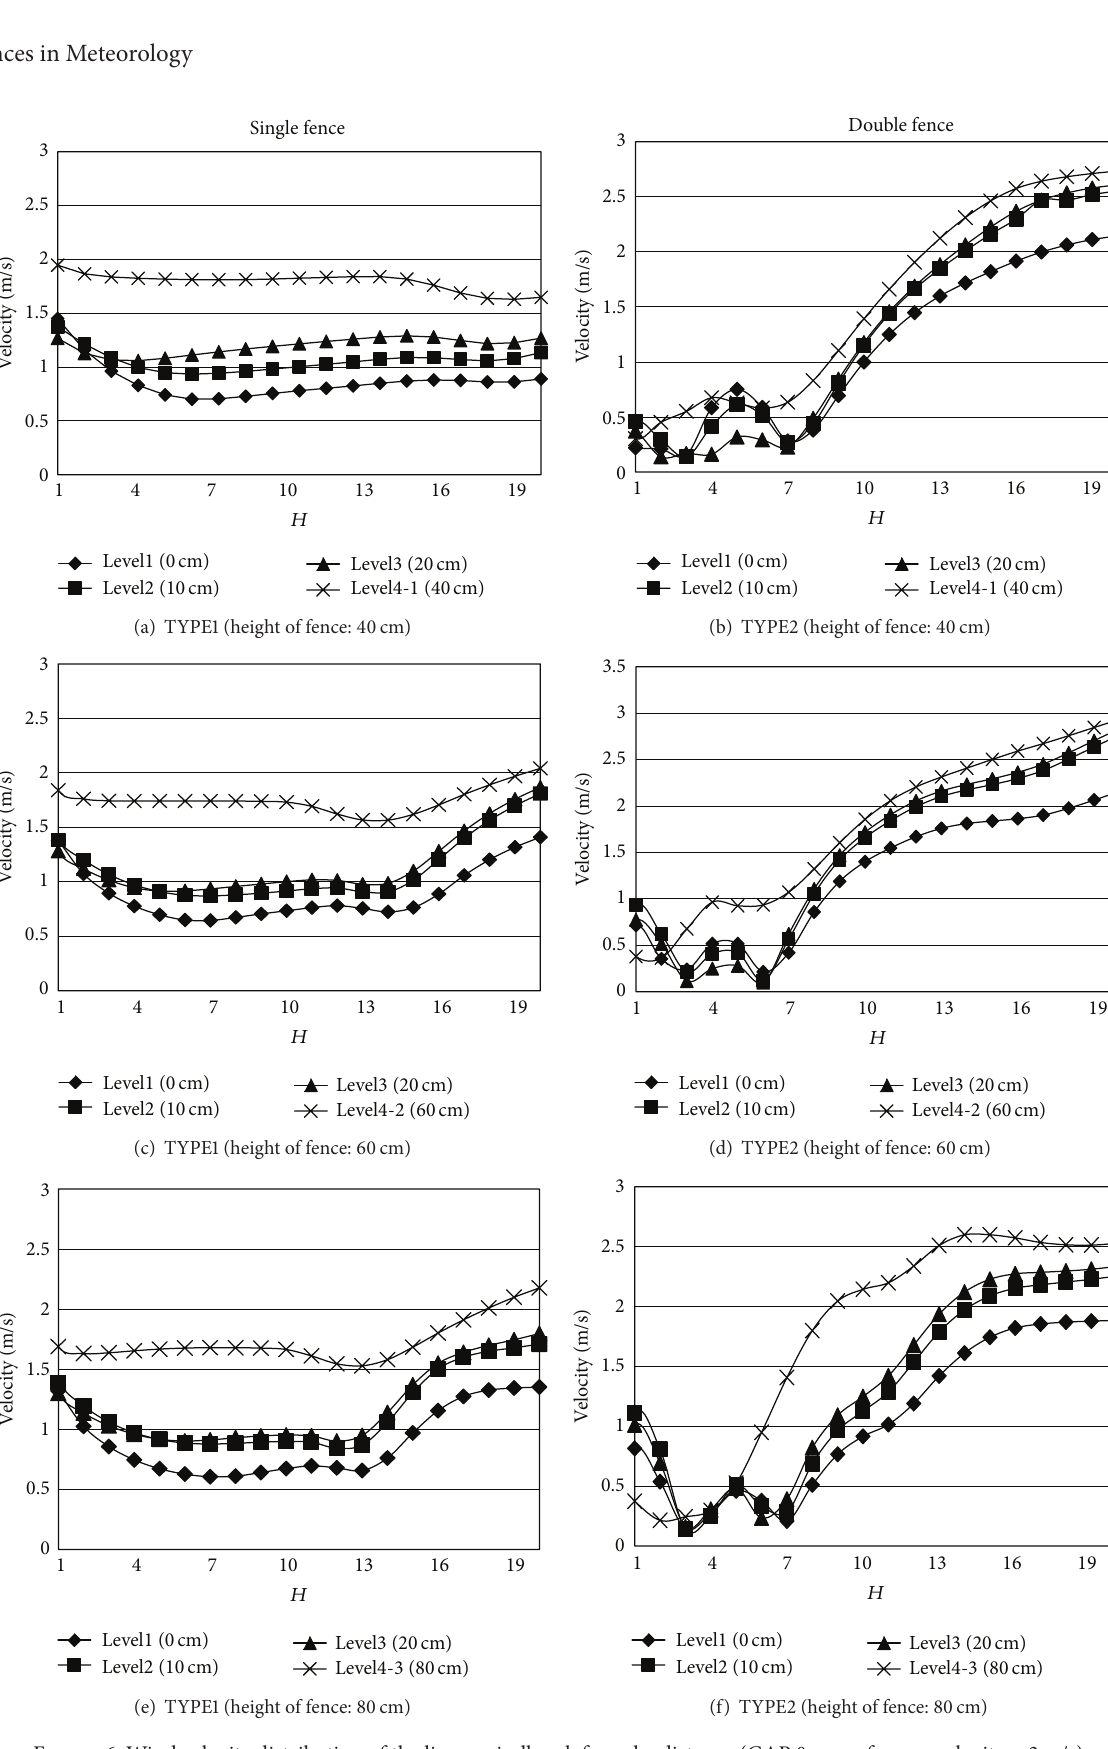
Figure 6: Wind velocity distribution of the linear windbreak fence by distance (GAP 0 cm, reference velocity =